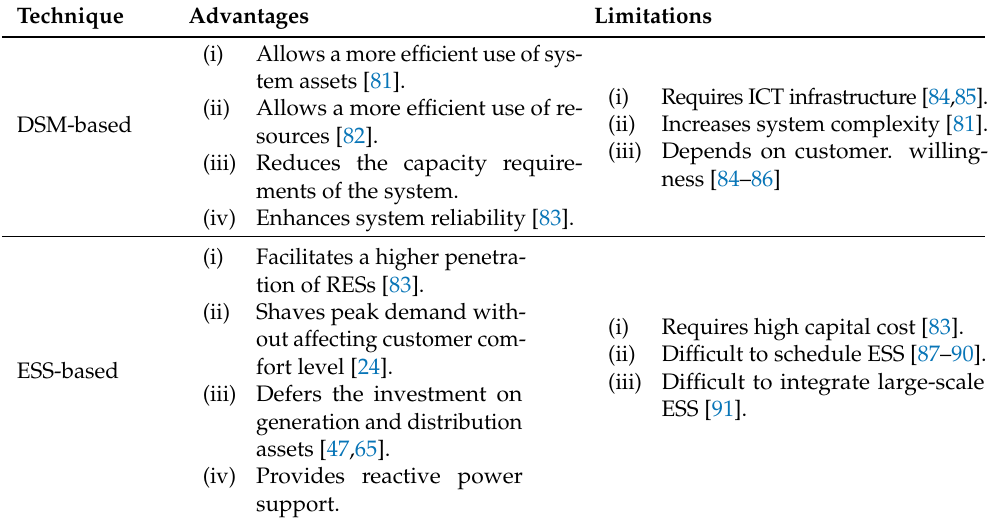
Table 1. A summary of advantages and limitations of different peak shaving